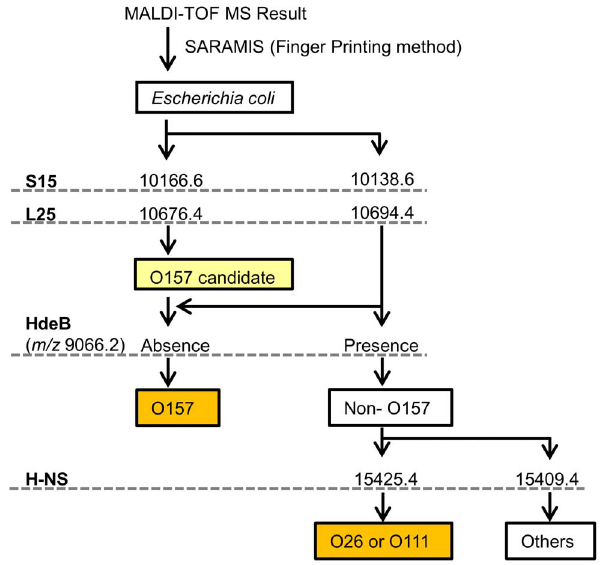
Figure 3. Strategy for distinguishing between E. coli strains O157, O26, O111 and the others using four biomarker peaks in MALDI-TOF MS.